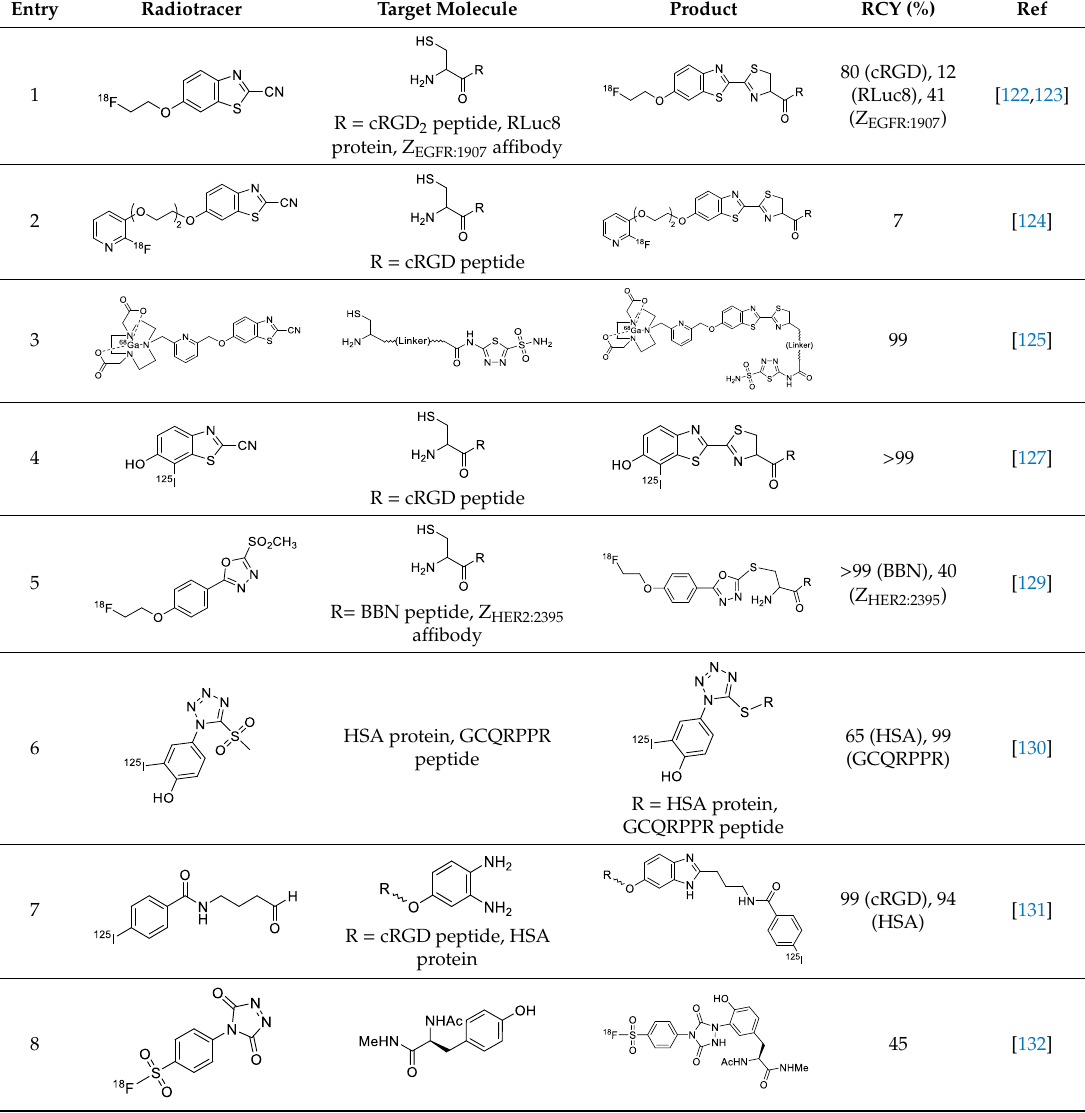
Table 4. Aromatic prosthetic groups for radiolabeling reactions.